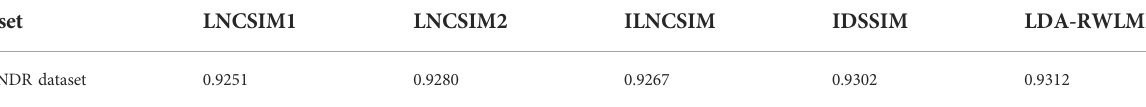
TABLE 1 AUCs of LDA identi fi cation approaches on the MNDR